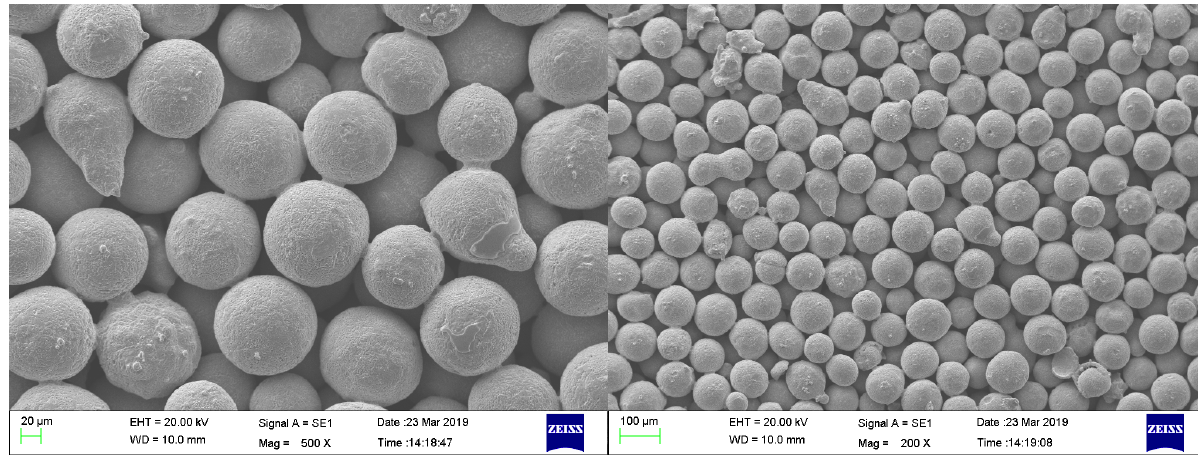
Figure 3. SEM photo of copper porous structure (diameter range 96–106 μ m).